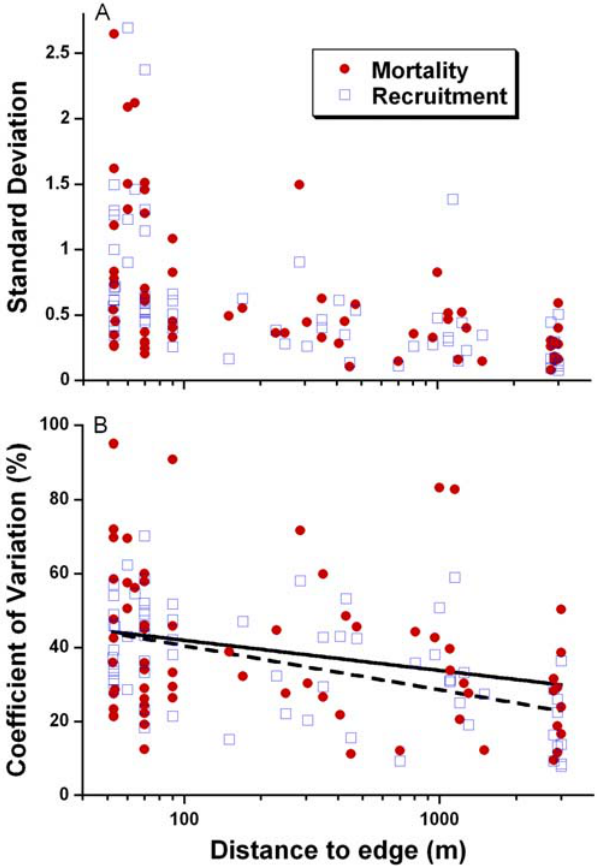
Figure 2. Pronounced temporal variability of tree mortality and recruitment rates near Amazonian forest edges. This variability is measured by (A) standard deviations and (B) coefficients of variation of among-census variation for 1-ha plots. In (B), the solid regression line is for mortality ( F 1,64 =5.68, R 2 =8.2%, P =0.02) and the dashed line for recruitment ( F 1,64 =27.30, R 2 =29.9%, P , 0.0001).